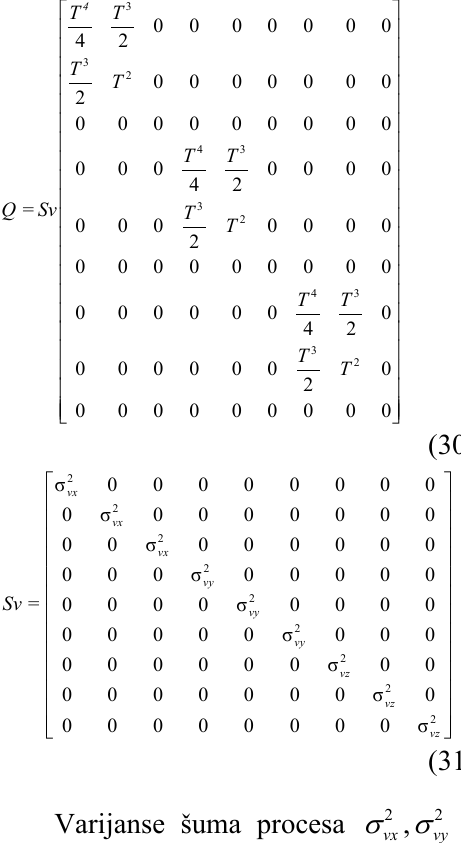
voa (cid:154)uma (vrednosti varijanse) smanjuje oscilatornost procesa, ali uve ć ava gre(cid:154)ke estimacije i predikcije. Po č etne vrednosti varijansi